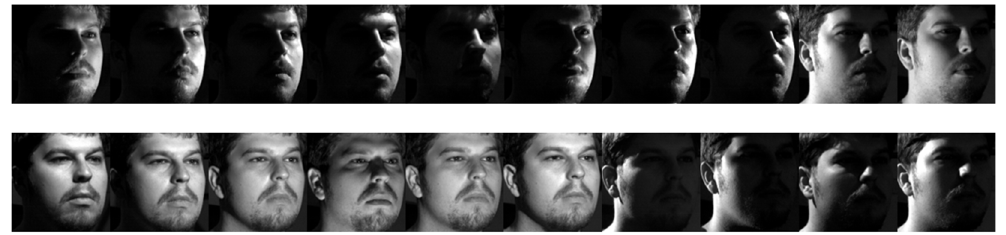
Figure 5. Examples of the Yale B’s extended face database.